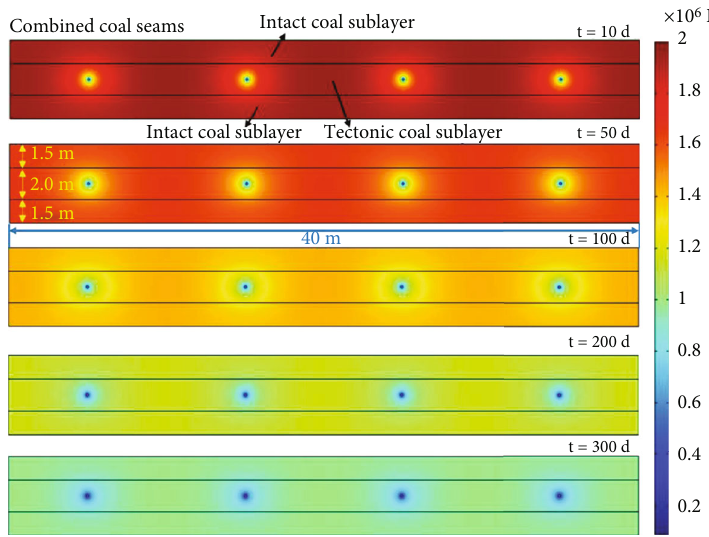
Figure 3: Gas pressure distribution at di ff erent extraction times.